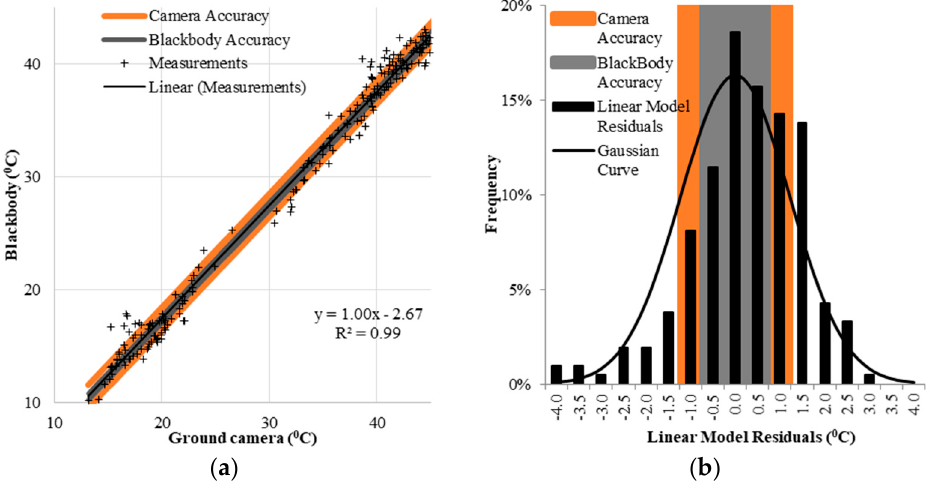
Figure 5. Temperature camera–blackbody comparison for 213 individual measurements. A linear model with a unit slope (1:1) and a constant bias ( − 2.67 °C) fitted the camera bias value over 3 years of study. Temperature values below 30 °C for the ground camera axis belong to early morning measurements, higher values are for Landsat overpass and mid-afternoon times ( a ); Reported accuracies from blackbody and camera manufacturers can explain up to 48% (gray region) and 68% (orange region) of linear model residuals variability, respectively ( b ). Table 4. Statistics for Temperature camera—blackbody linear model analysis.